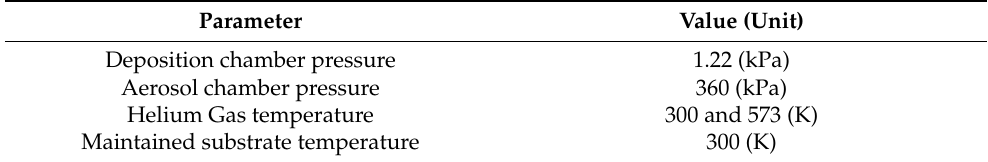
Table 2. Deposition parameters of the AD simulation